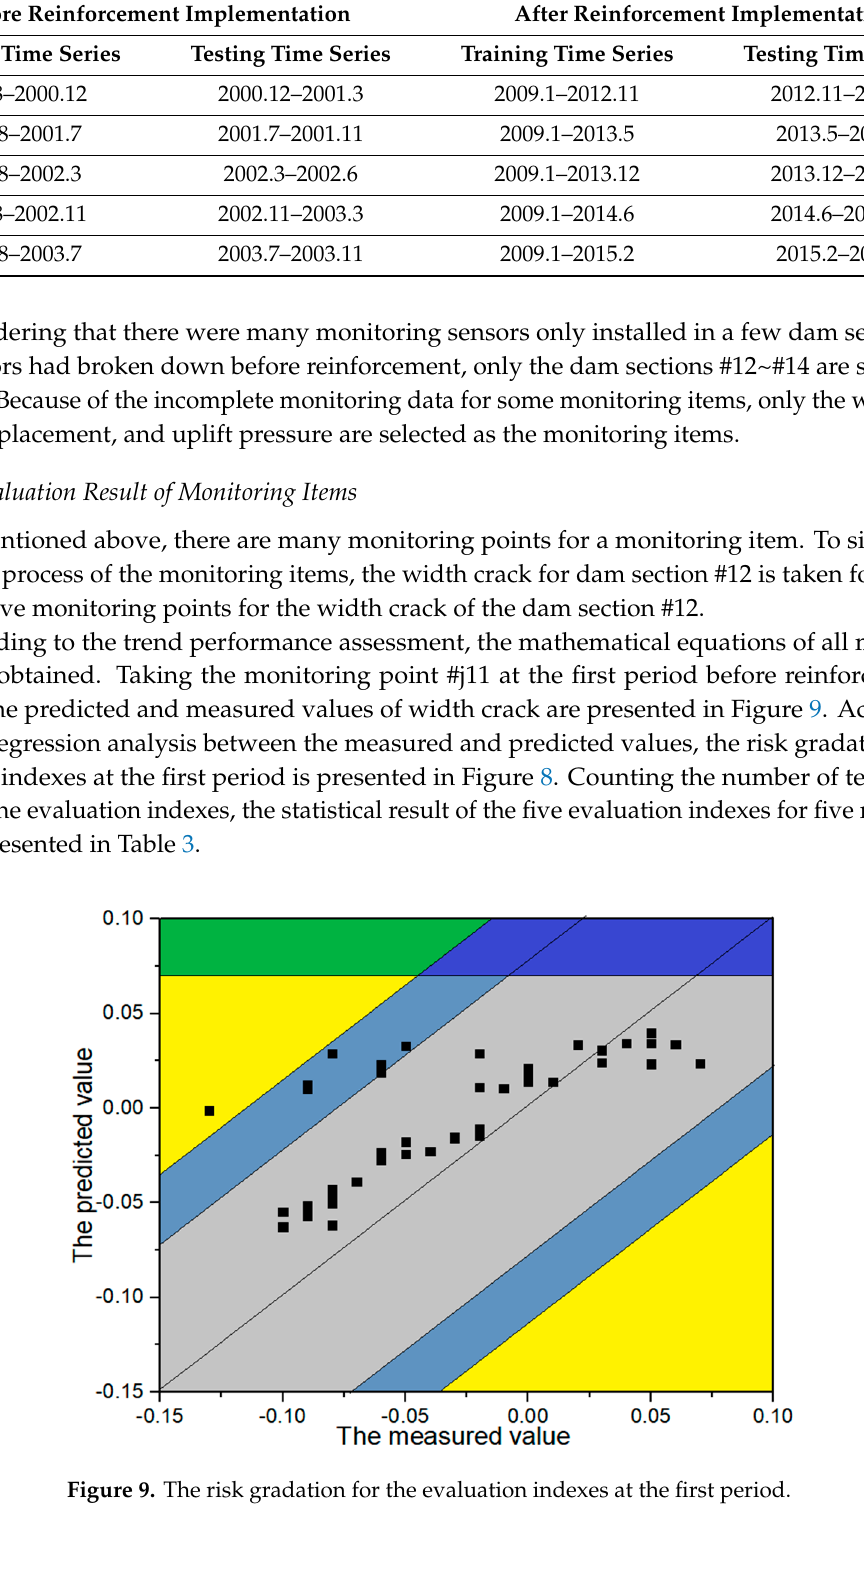
Table 2. Five division for the time series before and after reinforcement.